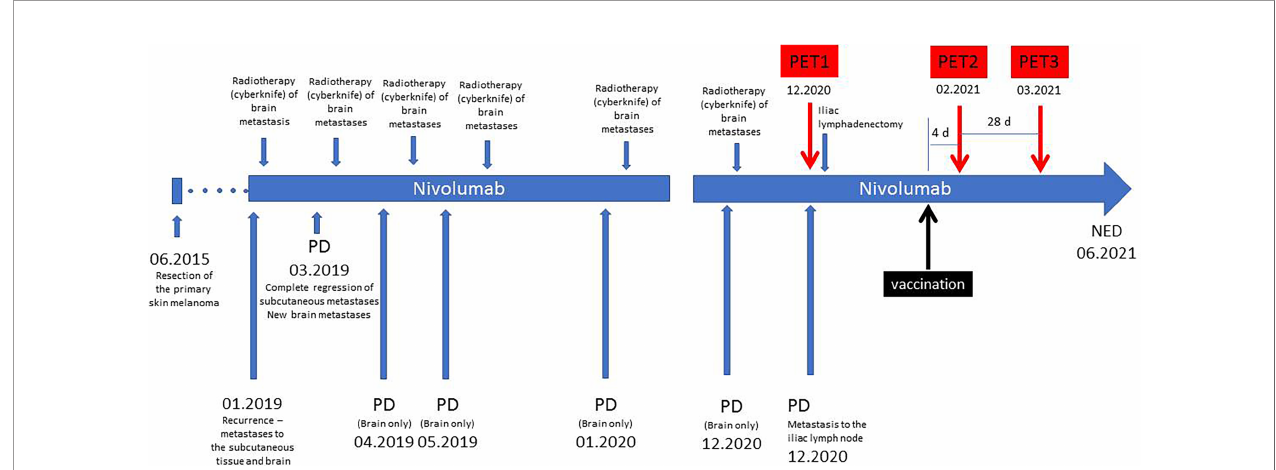
FIGURE 1 | Timeline of the treatment. PD, progression of the disease; NED, no evidence of the